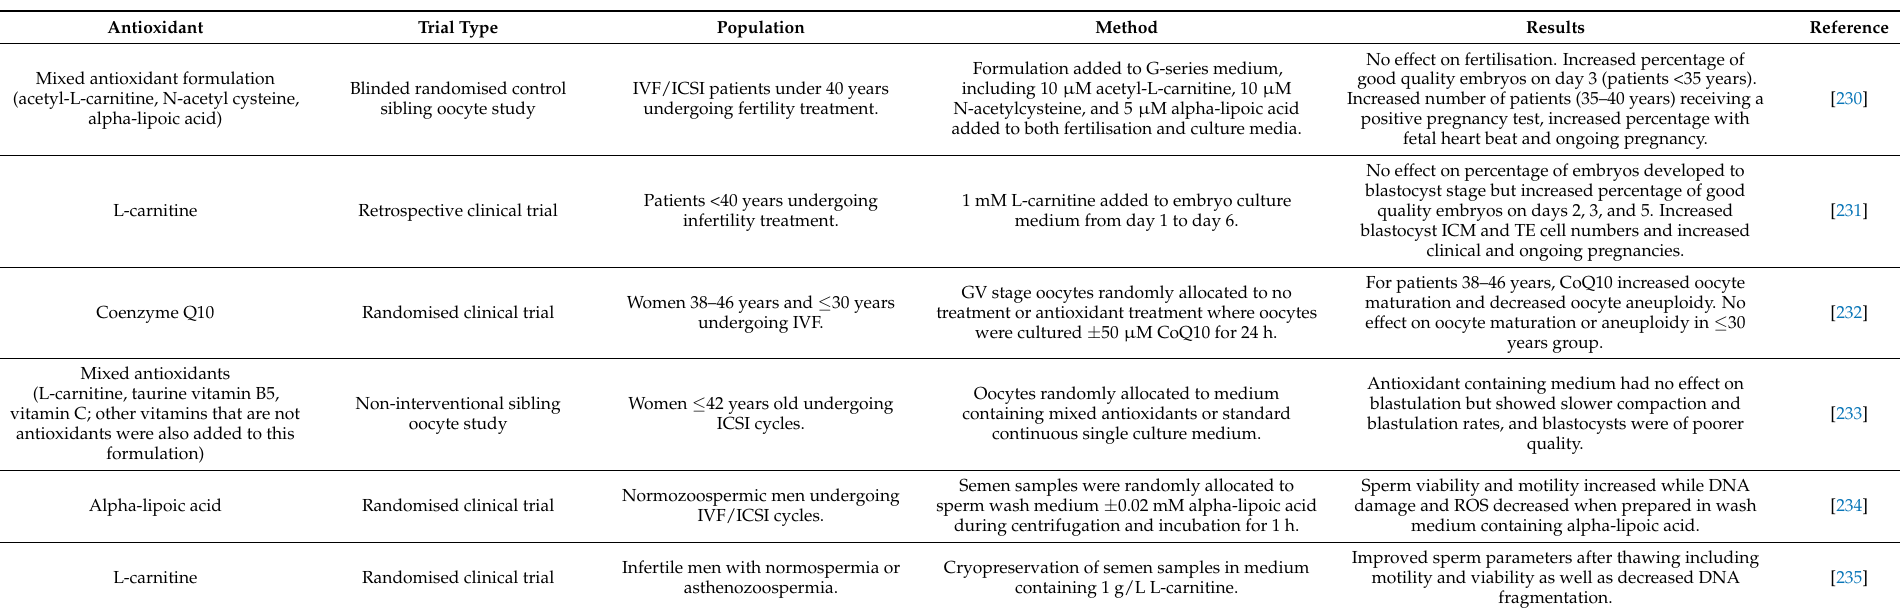
Table 2. Clinical trials using antioxidants in vitro and their effect on oocyte, sperm, and embryo